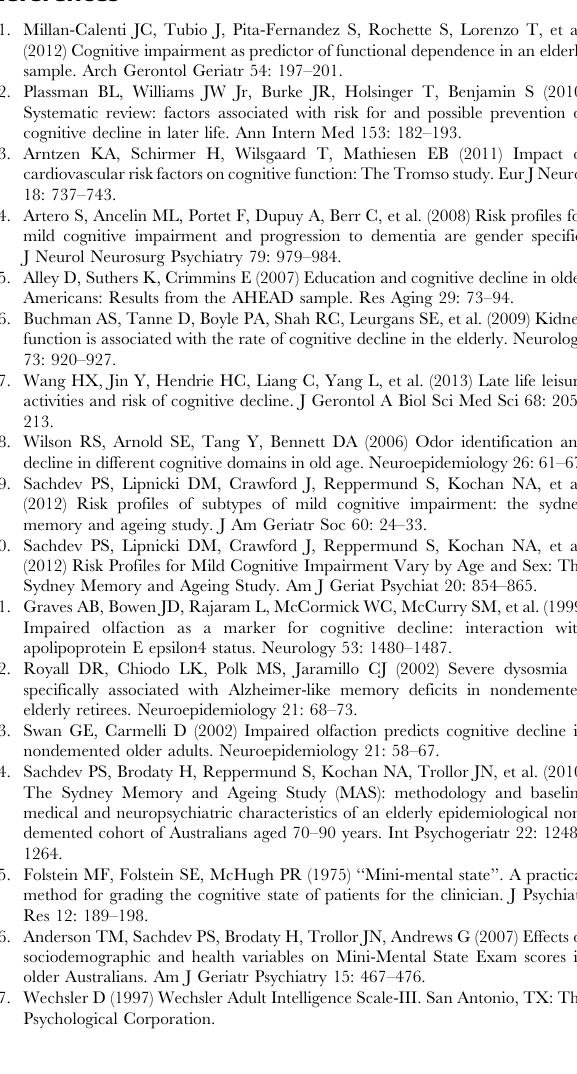
Table S1 PARs for decline in cognitive